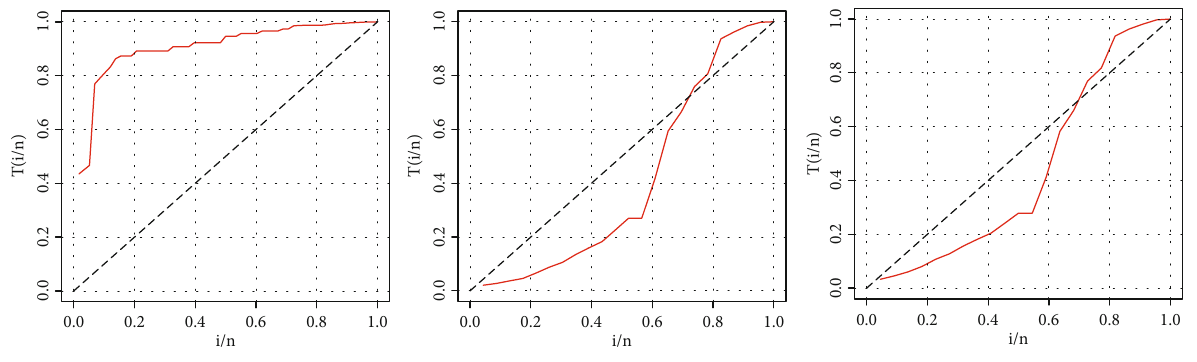
Figure 11: TTT plots of data sets. Table 4: ML estimates along with SEs of the fi tted